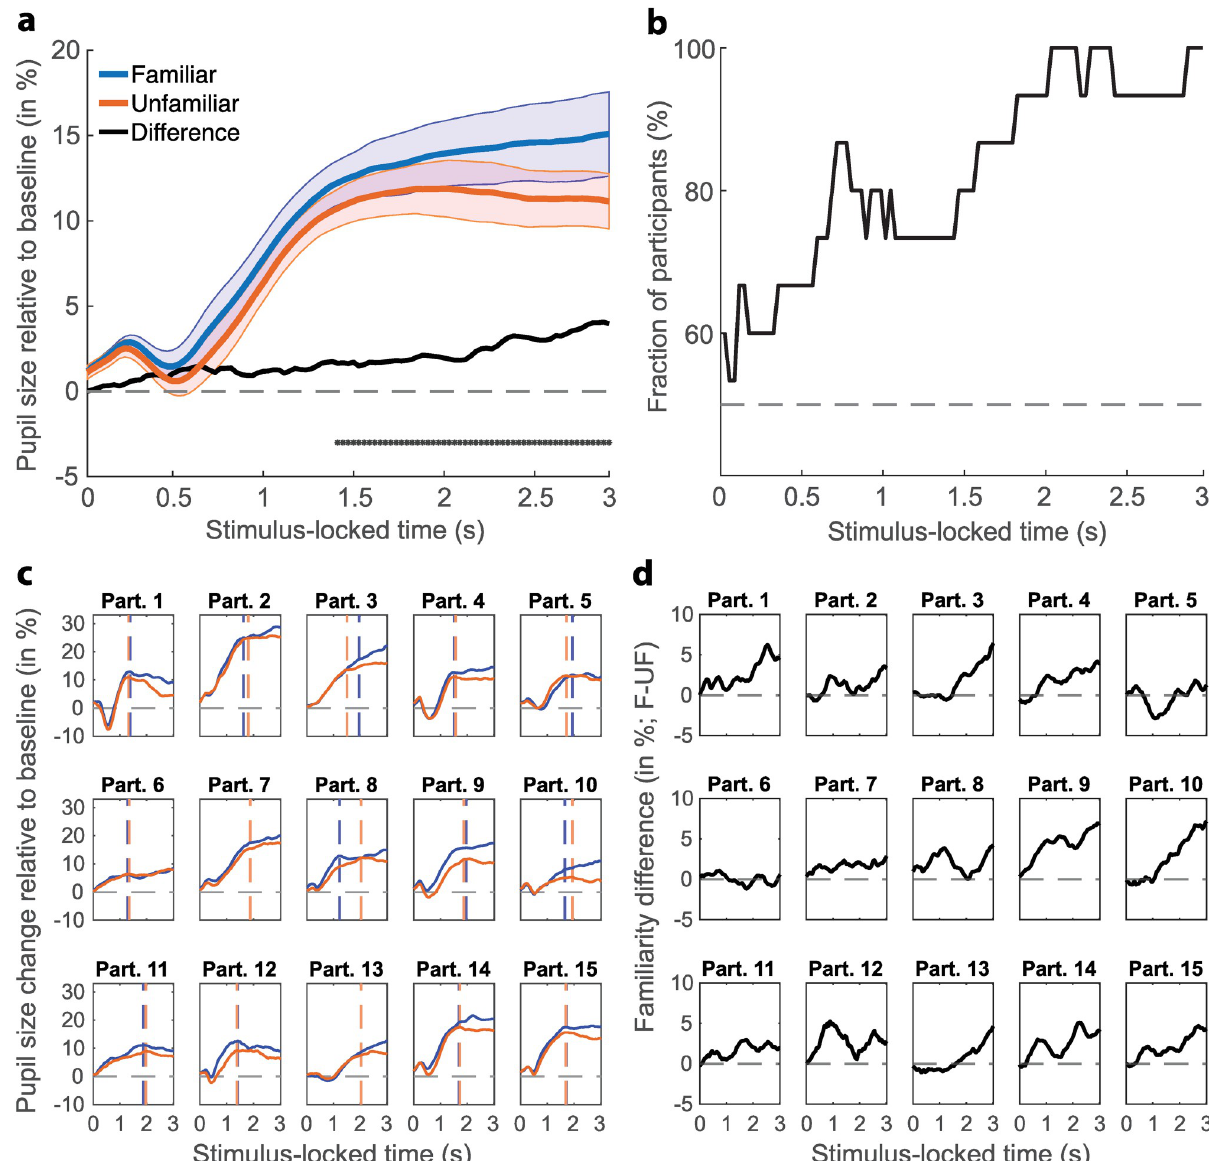
Fig 2. Pupil size change relative to baseline and individual dynamic range. a) Comparison of pupil responses to both familiar (blue) and unfamiliar (orange) intact branded images over time. Colorful lines show the 5% trimmed mean and shaded areas the bootstrapped standard errors of the mean. As a result of the temporal cluster-based bootstrapping procedure, the solid black line depicts the bootstrapped difference between the two familiarity conditions and black dots denote clusters of significant windows. The statistical test was conducted for every window with 30 ms onset intervals (i.e., 30 Hz). A data-driven minimum cluster size of 30 consecutive significant windows were required for a significant cluster. Dashed grey line depicts the median baseline pupil size of the last 150 ms leading up to the viewing of the intact image. The light blue and orange patches represent the bootstrapped standard errors for their respective familiarity condition. b) Fraction of participants showing an effect in the direction of the entire group; computed for each window. Dashed grey line depicts 50% of participant showing the same effect as the group. c ) Individual participant-based comparison of pupil responses to both familiar (blue) and unfamiliar (orange) intact branded images over time. Vertical dashed lines indicate peak pupil responses within the first two seconds of viewing intact branded images by familiarity condition. If only one line is present both peaks were of identical latency. Color scheme as in panel a. All 15 participants shown. d) Individual difference between familiarity conditions (familiar–unfamiliar) relative to baseline and individual dynamic range in percent. Dashed grey lines depict the individual mean baseline across all trials of a participant. Note, black lines illustrate the effective difference and not the bootstrapped difference that is presented in panel